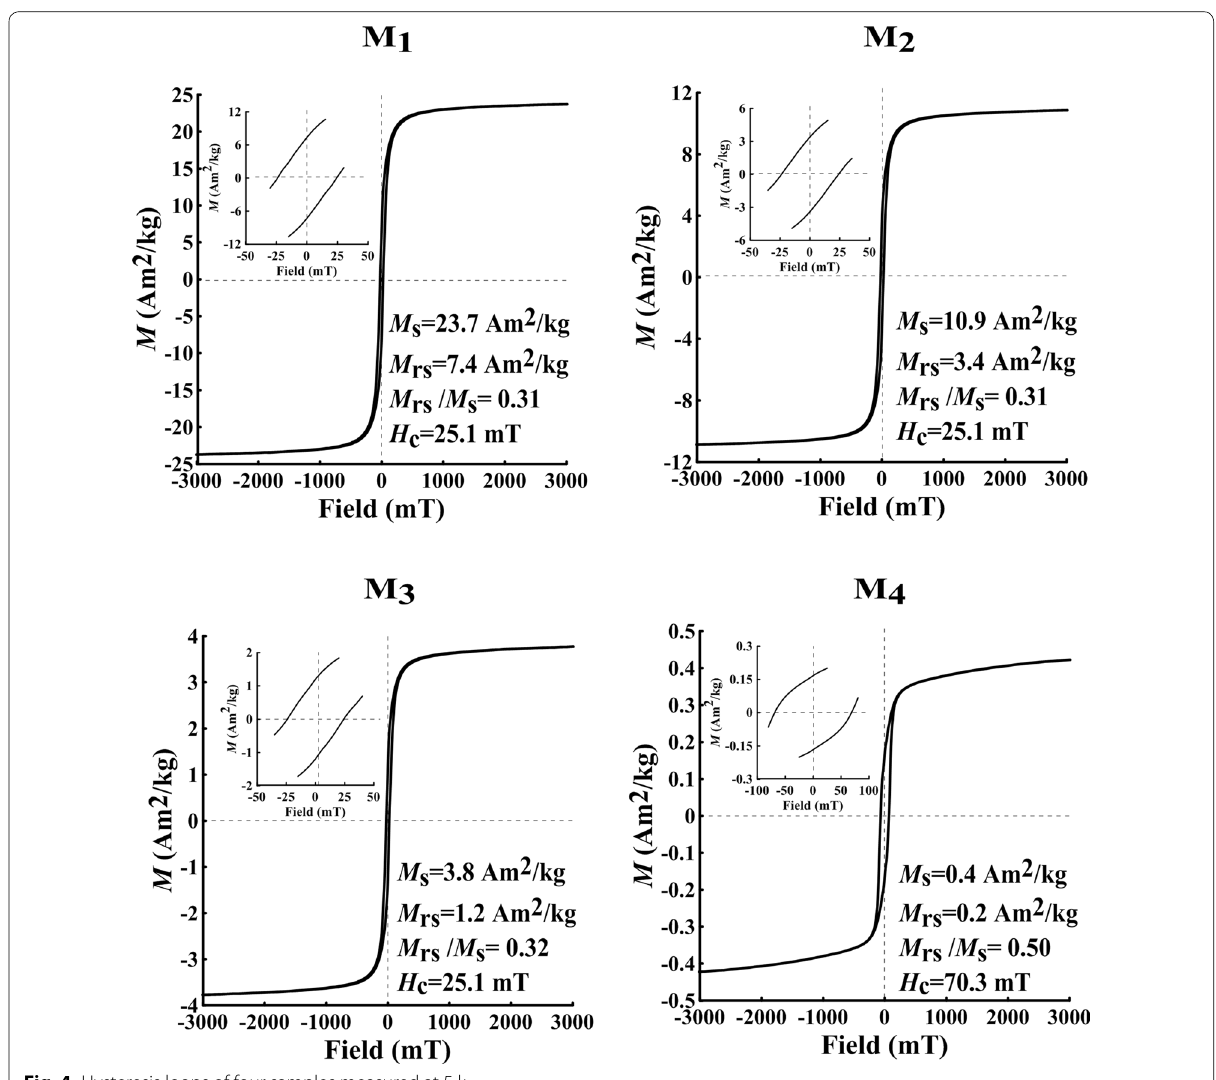
Fig. 4 Hysteresis loops of four samples measured at 5 k